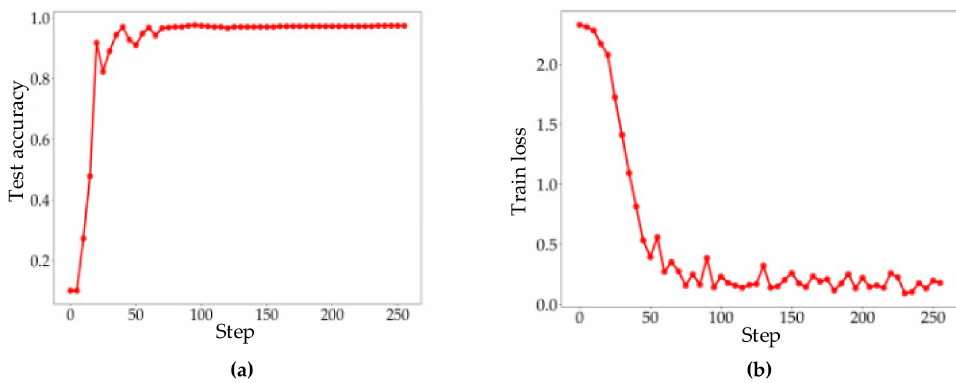
Figure 10. ( a ) Test accuracy; ( b ) train loss.